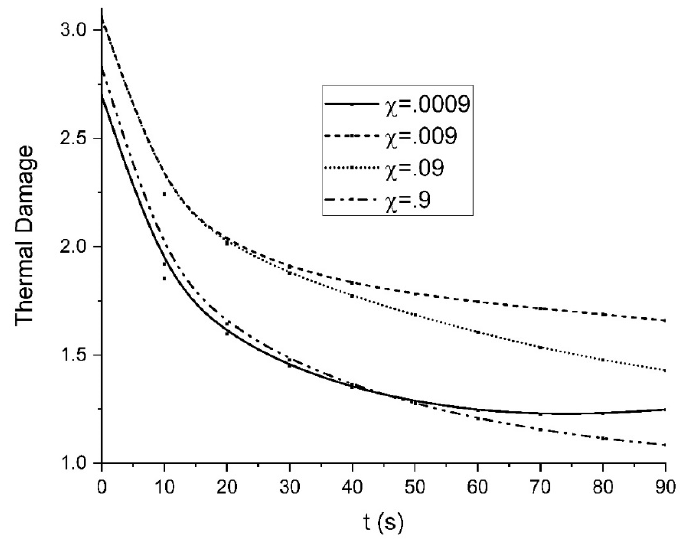
Figure 4. The variation of thermal damage at skin surface with different values of time-delay